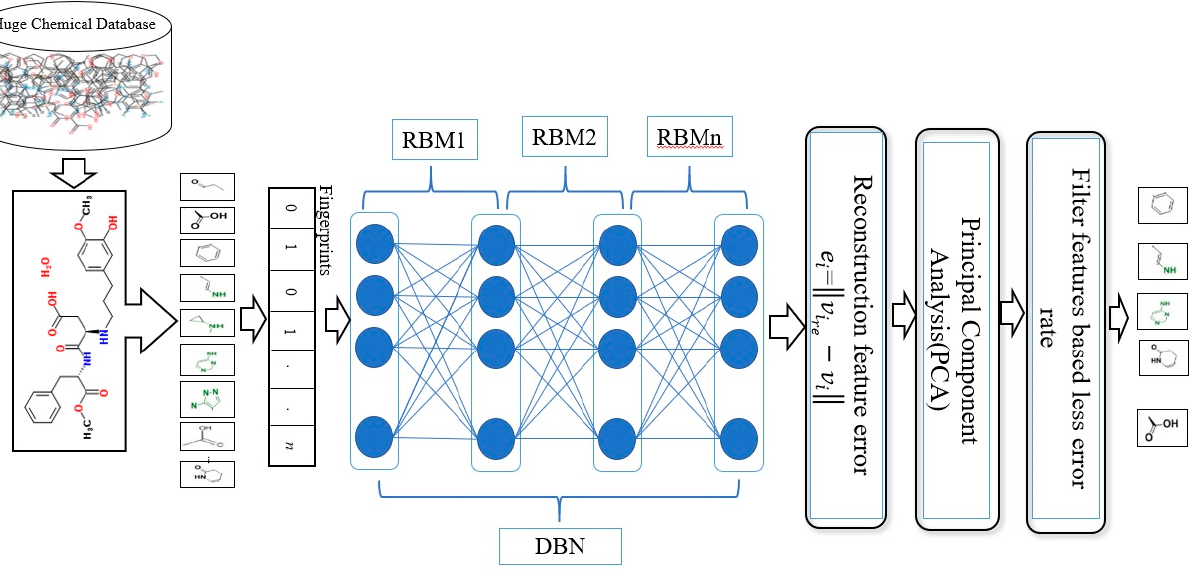
Figure 5. Dimensionality reduction and feature filtering processes.